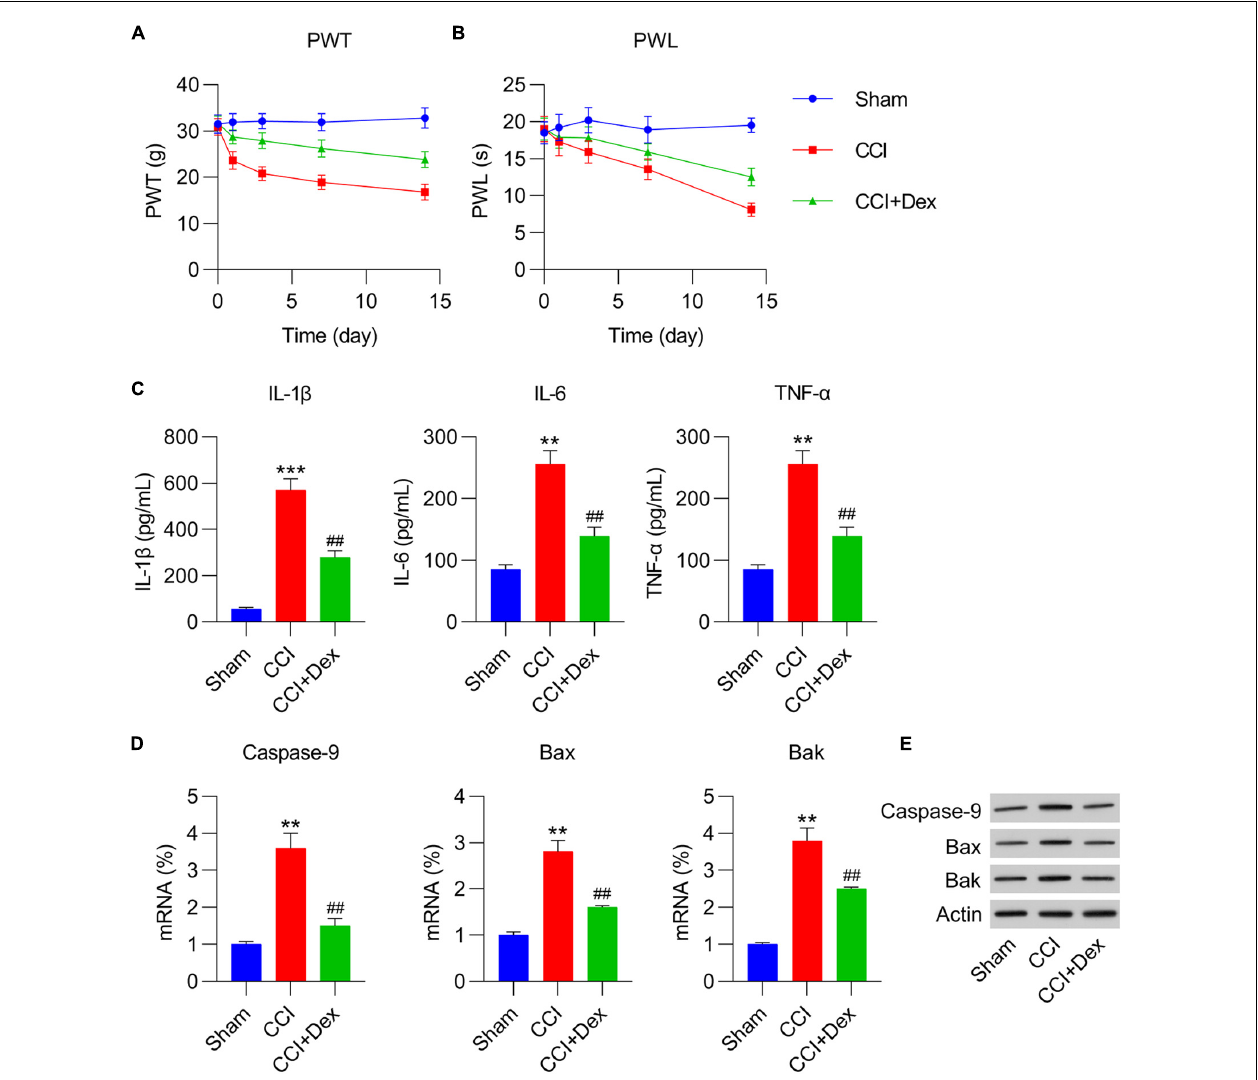
FIGURE 1 | Dexmedetomidine (Dex) mitigated chronic constriction injury (CCI)-induced neuropathic pain. (A) Paw withdrawal threshold (PWT) (g) at 0, 1, 3, 7, and 14 days after operation. (B) Paw withdrawal latency (PWL) (s) at 0, 1, 3, 7, and 14 days after operation. (C) IL-1 β , IL-6, and TNF- α expression levels were determined using enzyme-linked immunosorbent assay. (D) mRNA levels of caspase-9, Bax, and Bak in spinal cord tissues were determined using quantitative polymerase chain reaction. (E) Protein levels of caspase-9, Bax, and Bak in spinal cord tissues were determined using western blotting. ** P < 0.01, *** P < 0.001 vs. Sham group; ## P < 0.01 vs. CCI